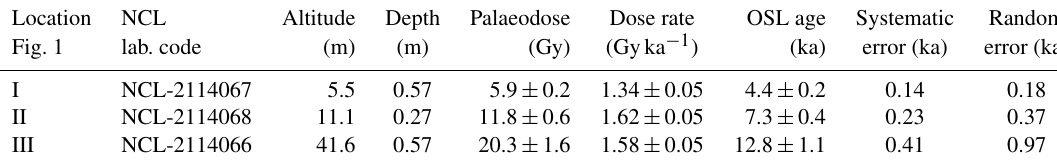
Table 2. OSL ages with uncertainty of 1 σ for 3 samples taken in the study area (Fig. 1). Location NCL Altitude Depth Palaeodose Dose rate OSL age Systematic Random Fig. 1 lab. code